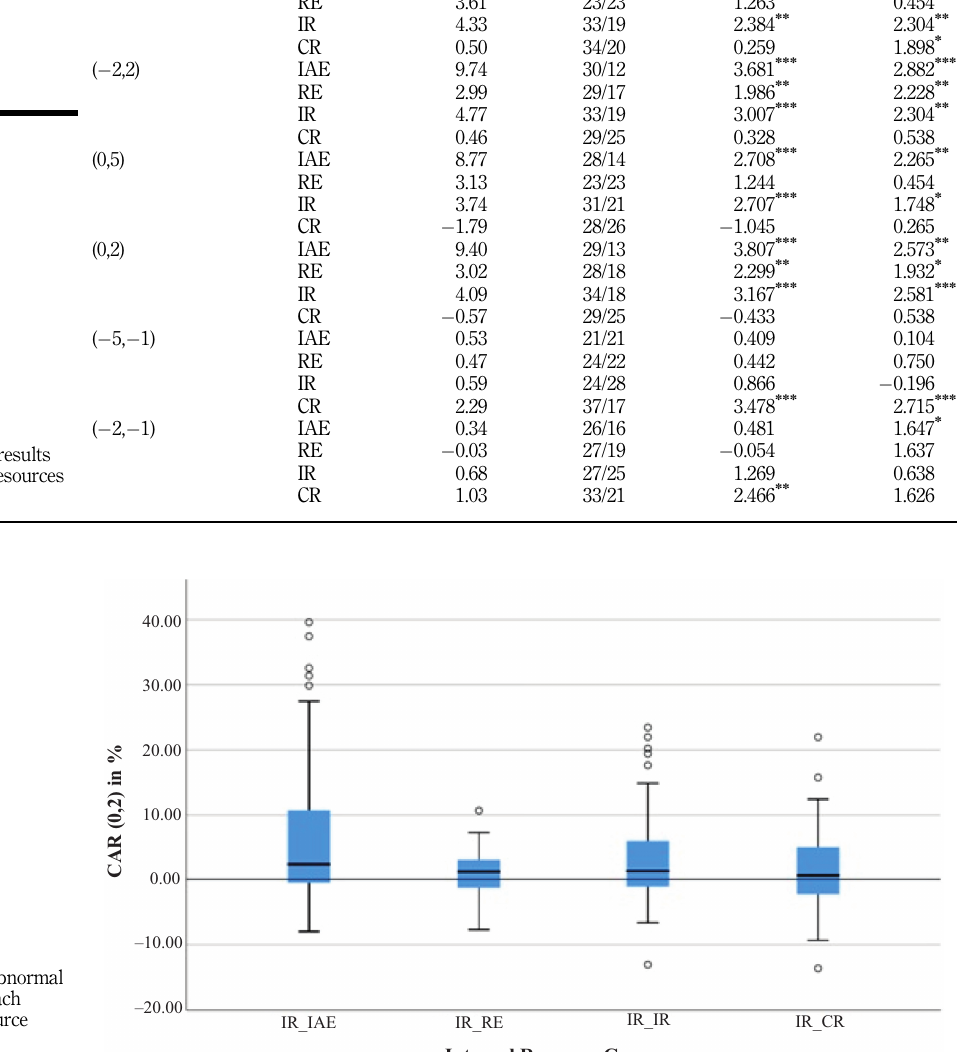
Figure 7. Box plots of cumulative abnormal returns for each internal resource